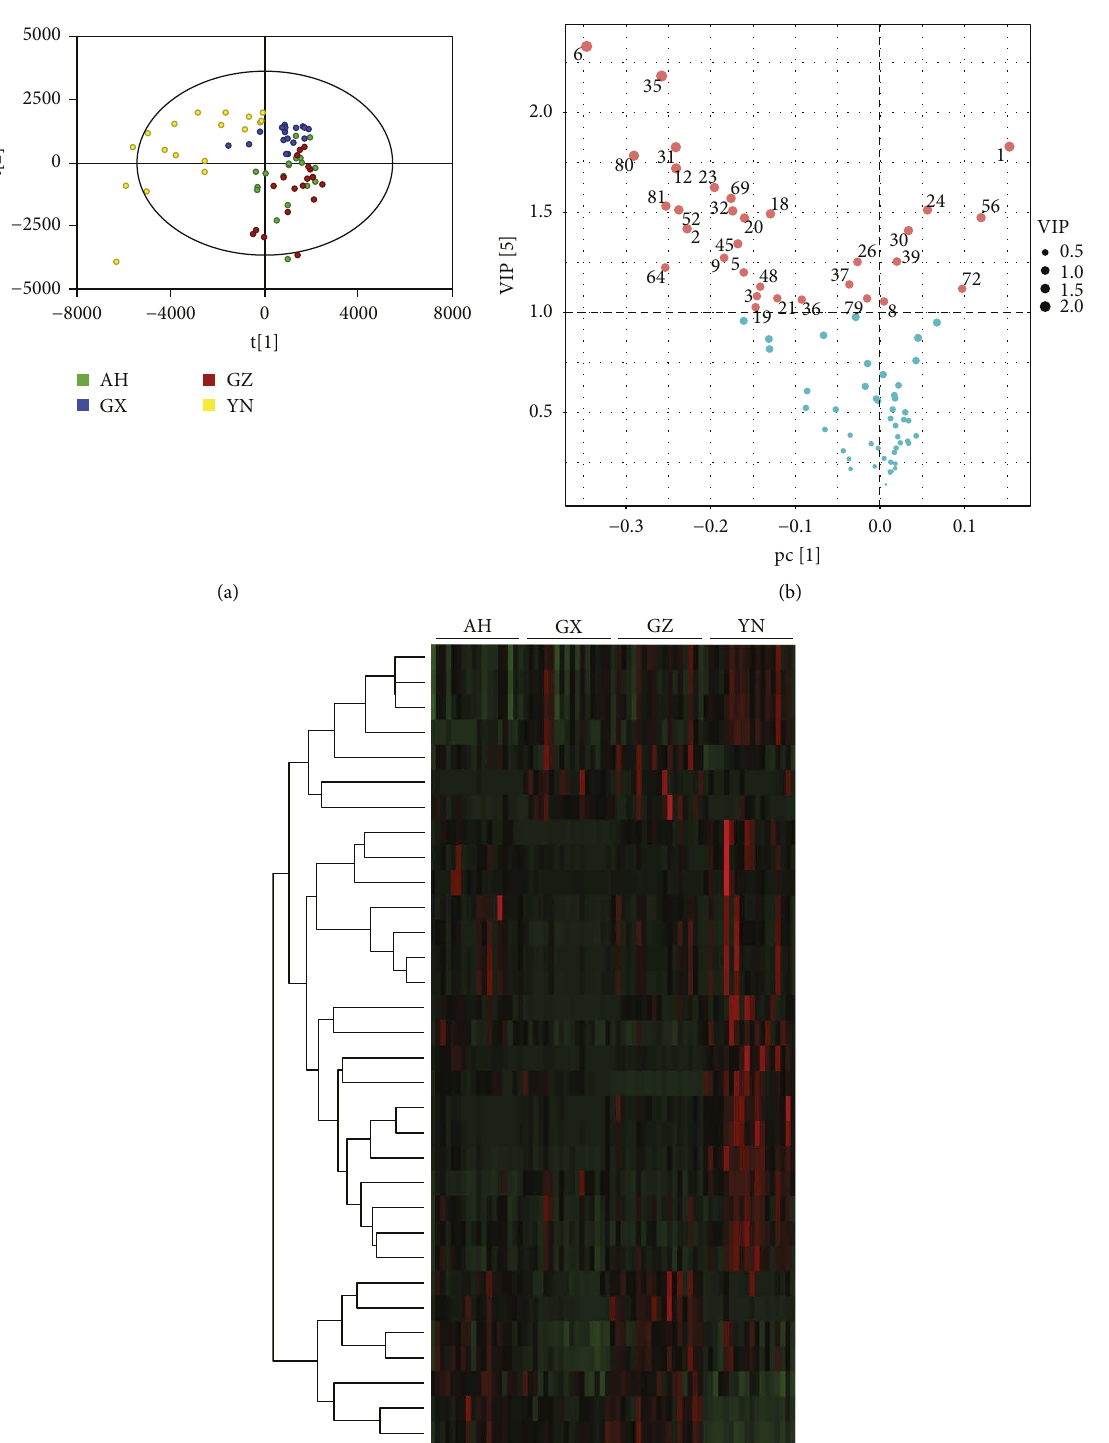
Figure 3: Discovery of diferential components of D. ofcinale from diferent regions. (a) PLS-DA of D. ofcinale from four regions. (b) VIP plot of D. ofcinale from four regions. (c) Heatmap of D. ofcinale from four